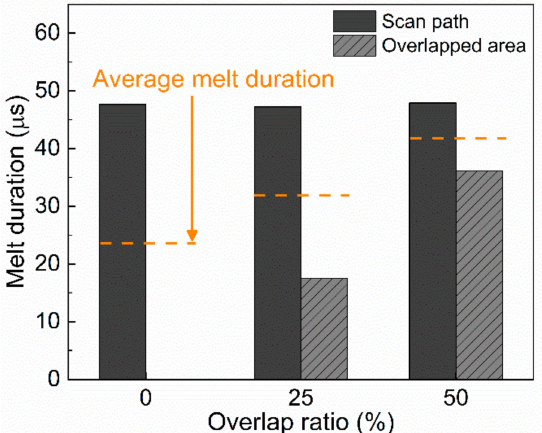
Figure 8. Melt duration (at point 3 in Figure 7) for different overlap